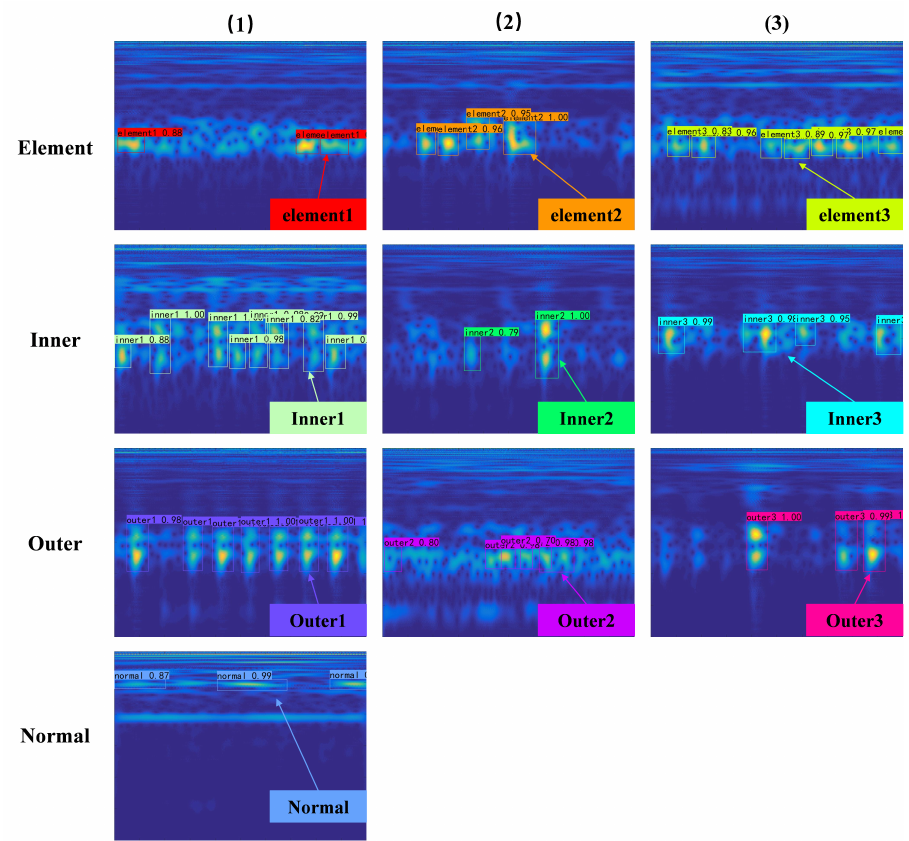
Figure 11. Data samples and their corresponding detection results in artificial damages (ResNet50 with